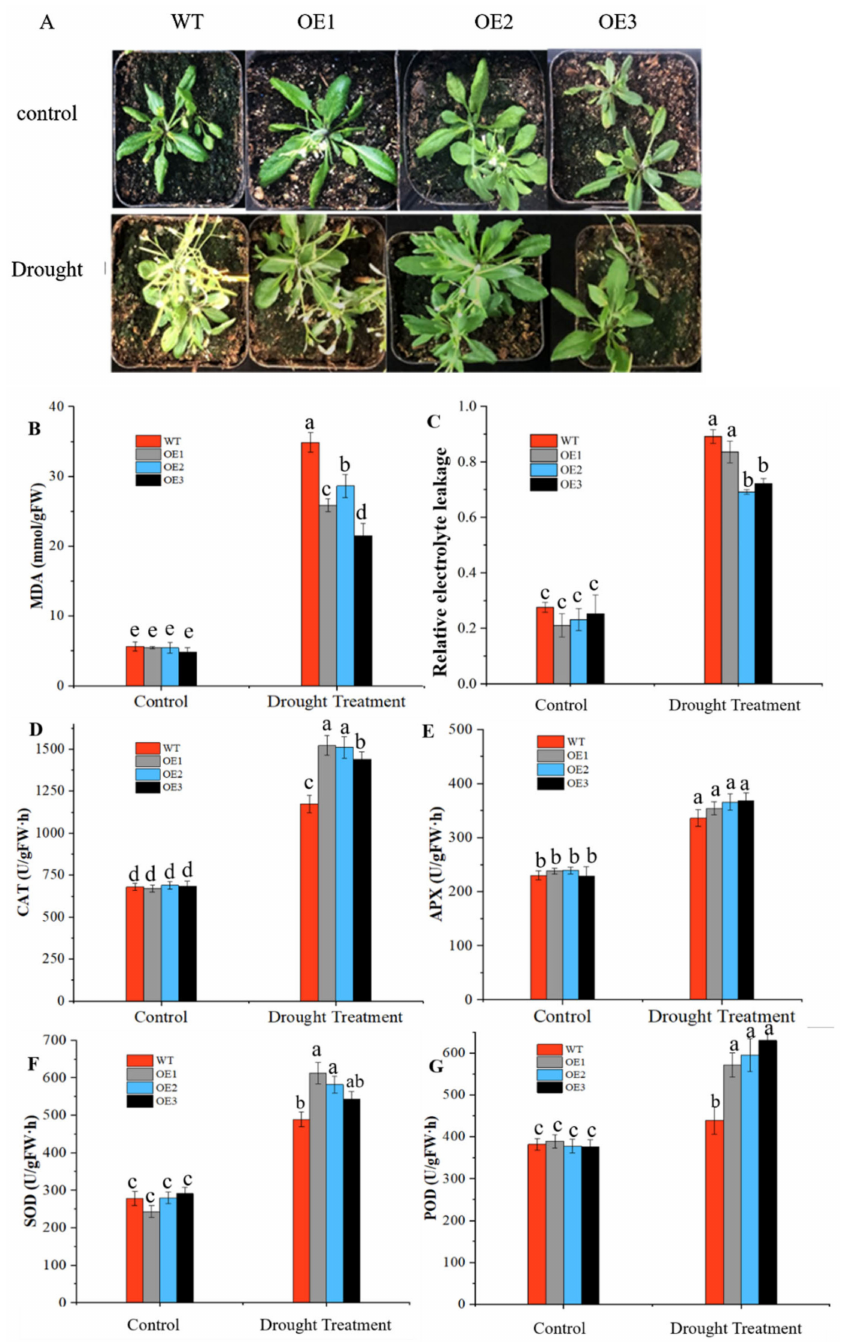
Figure 6. Drought resistance of transgenic CaHSP18.1a -OE Arabidopsis plants. ( A ) Phenotypes of wild-type (WT) and CaHSP18.1a -OE Arabidopsis ; ( B , C ) Malonaldehyde (MDA) content and relative electrolyte leakage (REL) of WT and CaHSP18.1a -OE Arabidopsis ; ( D – G ) Superoxide dismutase (SOD), catalase (CAT), peroxidase (POD), and ascorbic acid peroxidase (APX) activity of WT and CaHSP18.1a -OE Arabidopsis without watering for 10 days. Data are means with standard deviations of three biological replicates. Different letters denote statistical significance ( p ≤